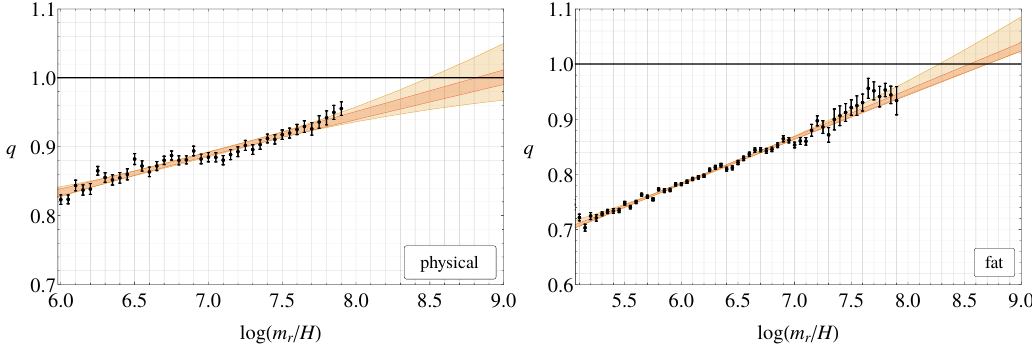
Figure 2: The spectral index of the instantaneous axion emission q as a function of / H ) ) for the physical (left) and fat string systems (right). The time (represented by log ( m r darker / lighter shaded regions correspond to the results of linear / quadratic fits to the data of the simulations (in black). The clear increase in q implies that the axion spectrum is turning IR dominated (i.e. q > 1), a regime that it will reach long before the physically relevant / H ) = 60 ÷ log ( m r